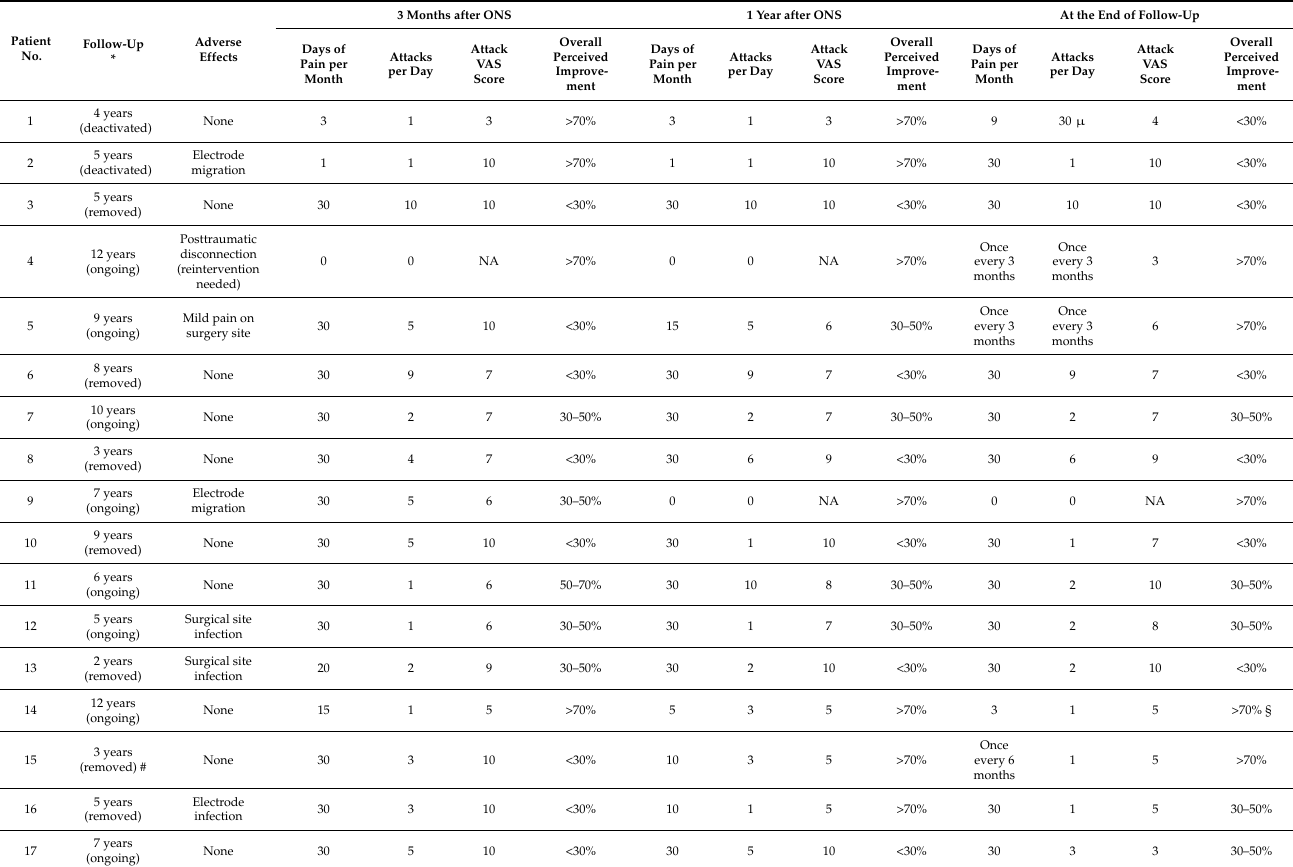
No.: number, ONS: occipital nerve stimulator, VAS: visual analogue scale, OnabotA: onabotulinumtoxin A, NA: not applicable. * Time from ONS placement to ONS deactivation or removal. Total number of headache attacks per day in patient’s diary. Number of headache cluster attacks was 8, remaining headaches had migraine or tension-type headache characteristics. µ Total number of headache attacks per day in patient’s diary. Number of headache cluster attacks was 8, remaining headaches had trigeminal neuralgia characteristics. § Cointervention: OnabotA started several years after ONS. # Removal performed by patient